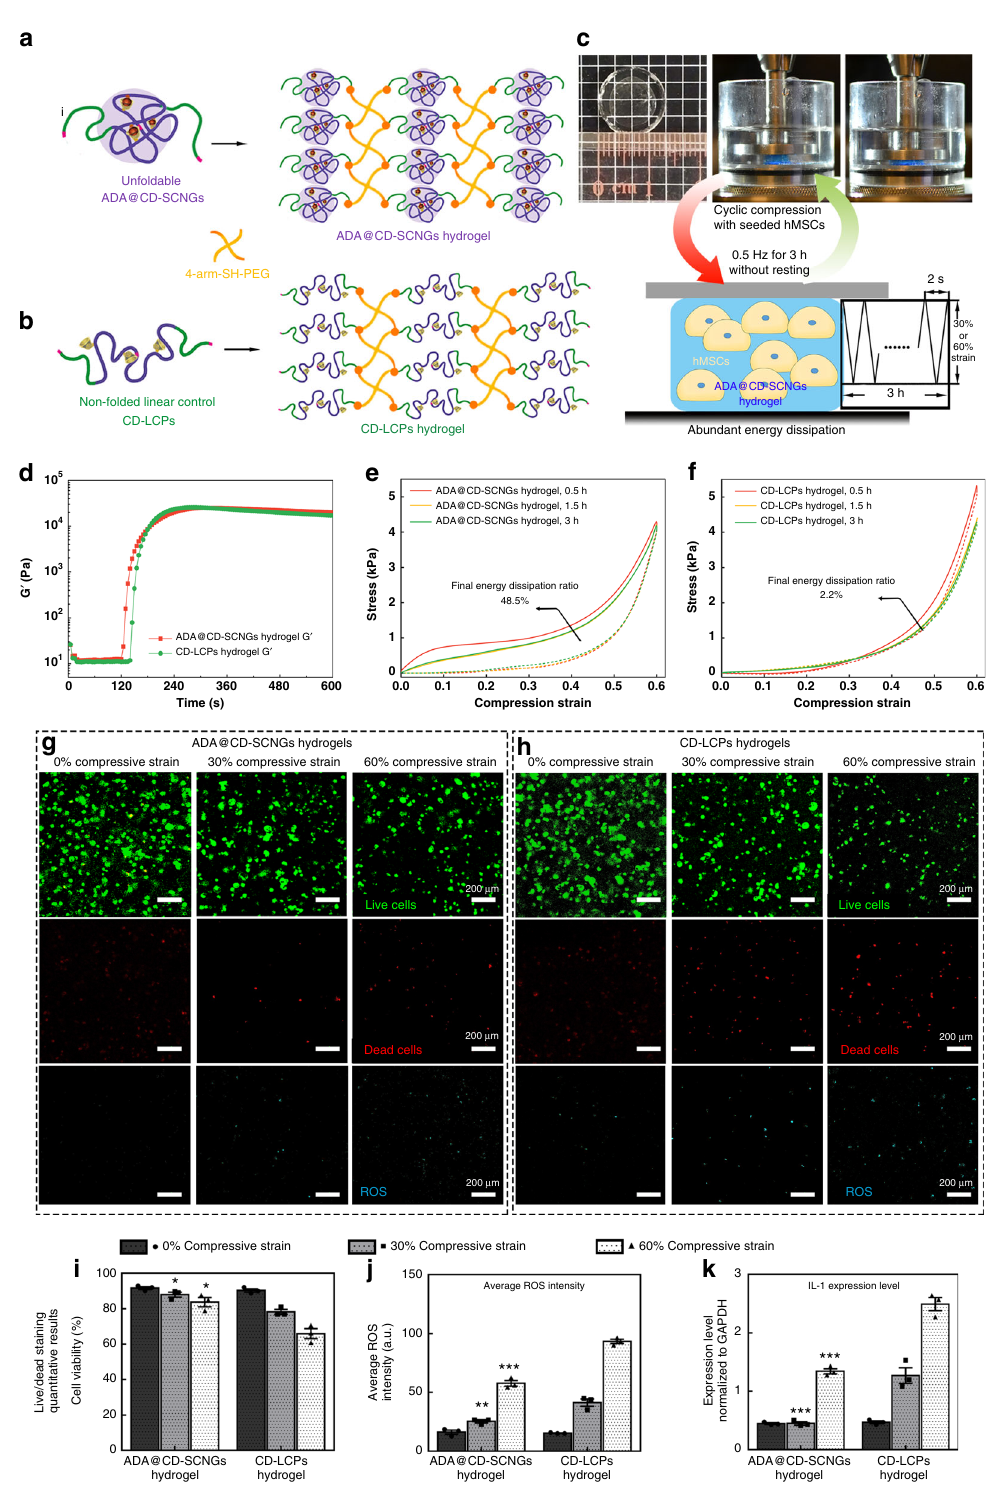
remained almost identical and showed an evident hysteresis loop, indicating the occurrence of consistent and substantial energy dissipation during the loading period (Fig. 6e, Supple- mentary Figs. 26 and 27). In contrast, the CD-LCP hydrogels without the folded domains showed nearly no hysteresis loops or energy dissipation (Fig. 6f). The ADA@CD-SCNG hydrogels dissipated 48.5% of the total loading energy under the excessive compressions corresponding to 22-fold higher dissipation ratios